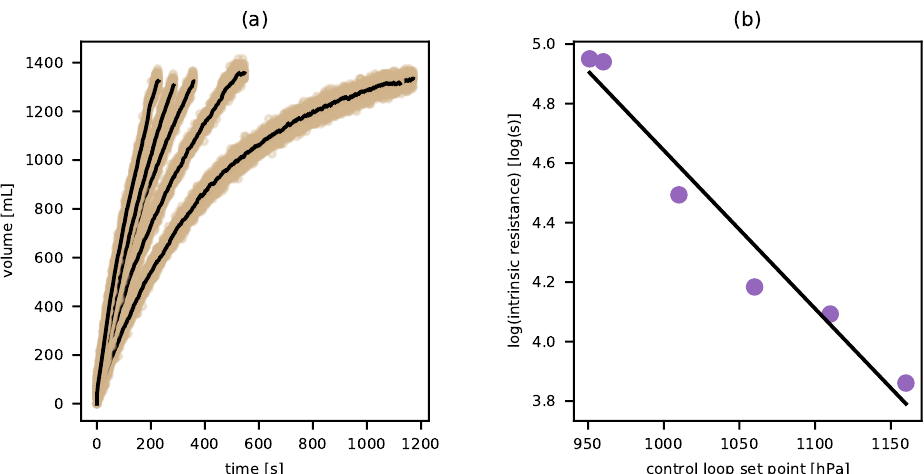
Figure 5. Percolation of water through sand under pressure. ( a ) Six samples of sand were brought to a wettability of 0 mL, and 1200 mL of water were passed through the test section while the pump control loop was set at 951 hPa, 960 hPa, 1010 hPa, 1060 hPa, 1110 hPa, and 1160 hPa respectively. ( b ) This semi-log plot shows the exponential variation of intrinsic resistance as a function of the setting of the pump motor control loop, the values of which are equivalent to the values of the induced pressure head